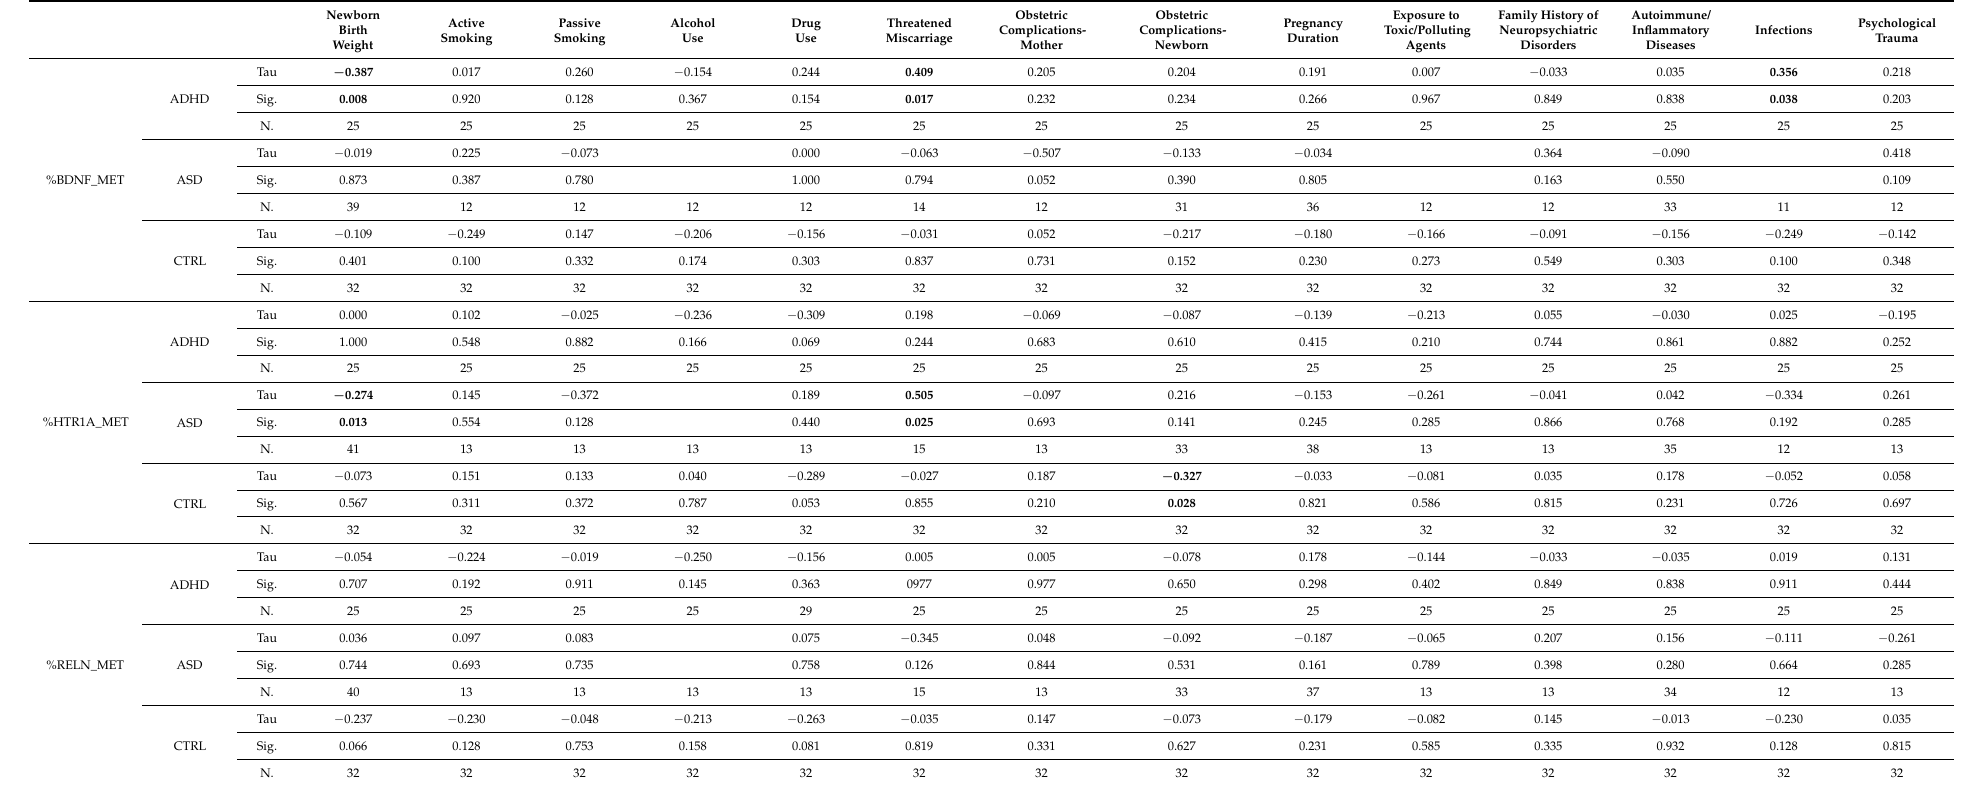
Table 3. Correlations between percentages of methylation for the four genes tested in this study and clinical variables. Statistically significant correlations are highlighted in